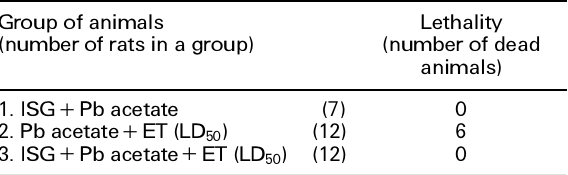
Table 1. Protecting effect of 10 mg / ml insoluble glycogen (ISG) on the endotoxin (ET) shock of rats. Data calculated on the basis of three separate